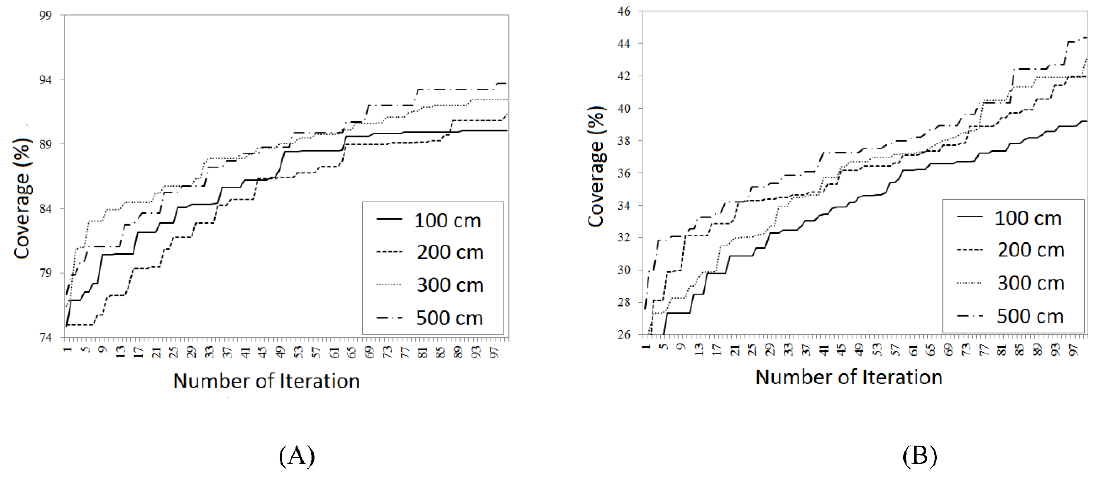
Figure 9. Convergence diagram based on genetic algorithm for: two-dimensional ( A ); and three-dimensional ( B ) raster model. Table 1. Values obtained based on genetic algorithm for two- and three-dimensional models. Dimension of